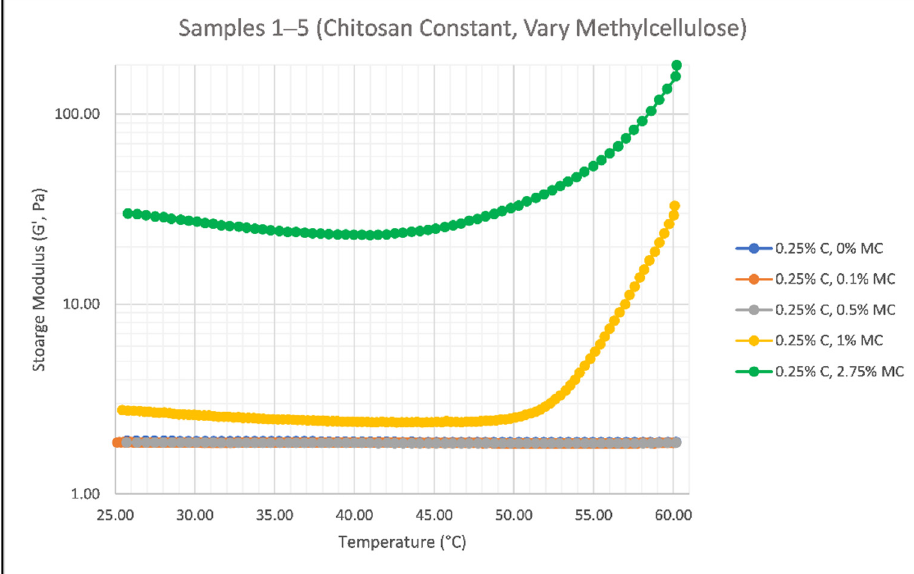
Figure 4. Effect of Methylcellulose Concentration on the Storage Modulus (G’) of Samples 1 (blue), 2 (orange), 3 (gray), 4 (yellow), and 5 (green) as temperature increases from 25 °C to 60 °C; where C is chitosan and MC is methylcellulose.